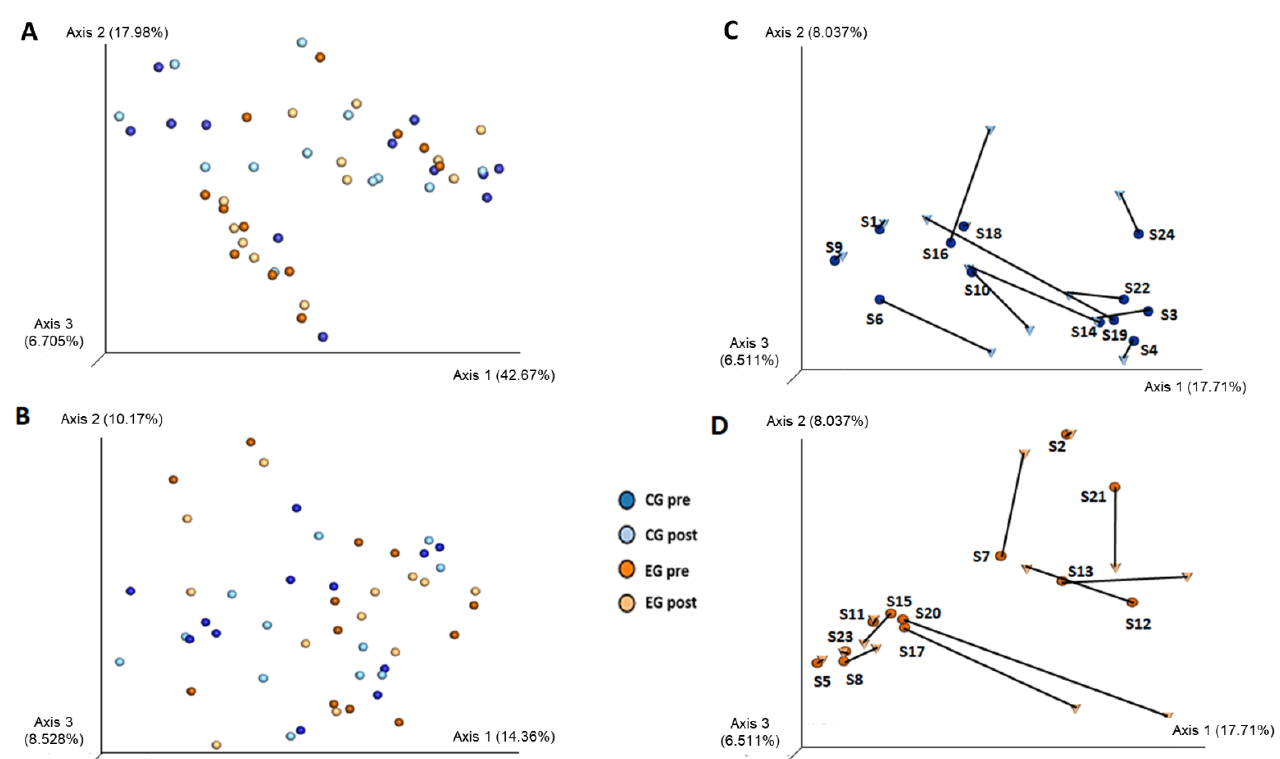
Figure 3. Principal coordinates analysis (PCoA) of gut bacteria composition. At the left of the figure, PCoA plots were constructed using ( A ) UniFrac weighted and ( B ) UniFrac unweighted indices, which were based on the 1667 microbial sequences from the rarefaction curve. Each point in the PCoA plot represents one individual, which is colored to represent the Group and Time measured. At the right of the figure, intraindividual variations of microbial community structure within ( C ) Control and ( D ) Exercise Groups using a Bray–Curtis dissimilarity PCoA plot at the genus level. There was no difference between Pre- and Post-intervention in either Group (PERMANOVA; p > 0.05). Axes 1, 2 and 3 represent the variation percentage that is explained by the tested variable, in this case exercise. Legend: CG pre: control group at pre-intervention (dark blue); CG post: control group at post-intervention (light blue); EG pre: exercise group at pre-intervention (dark orange); EG post: exercise group at post-intervention (light orange); S(number) in the figures ( C ) and ( D ) refers to each subject.